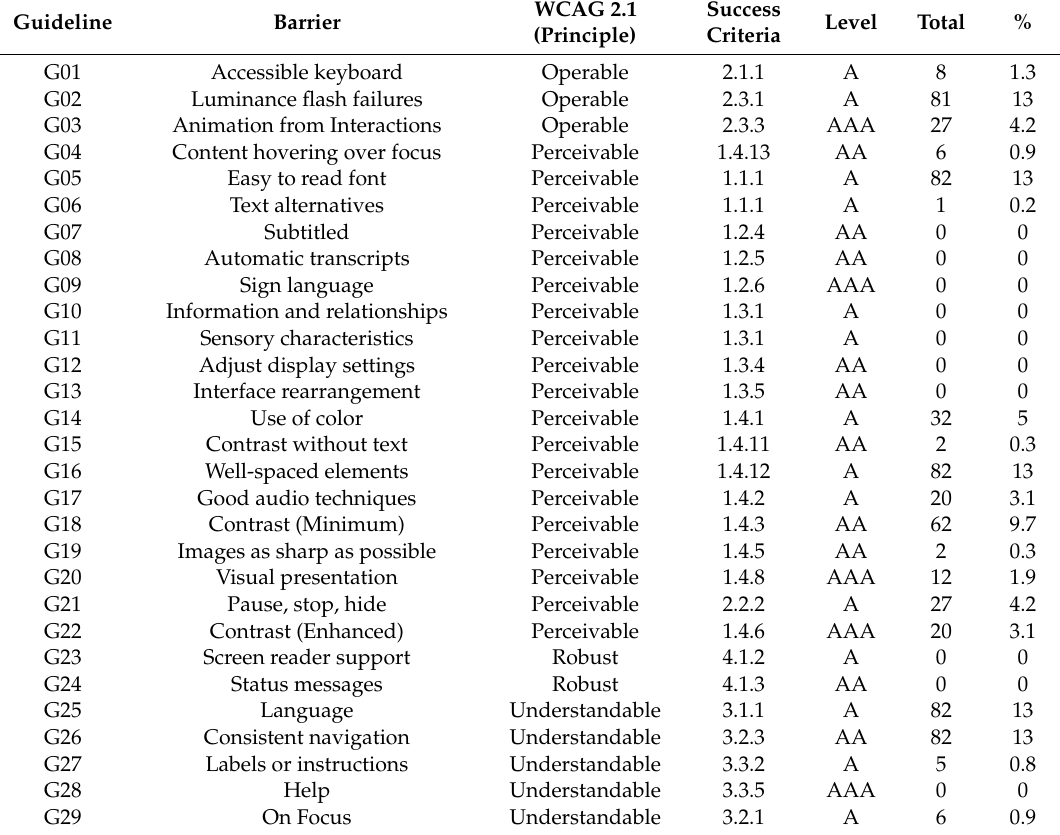
Table 3. Summary of Accessibility Evaluation in Serious Games with the Manual Method.